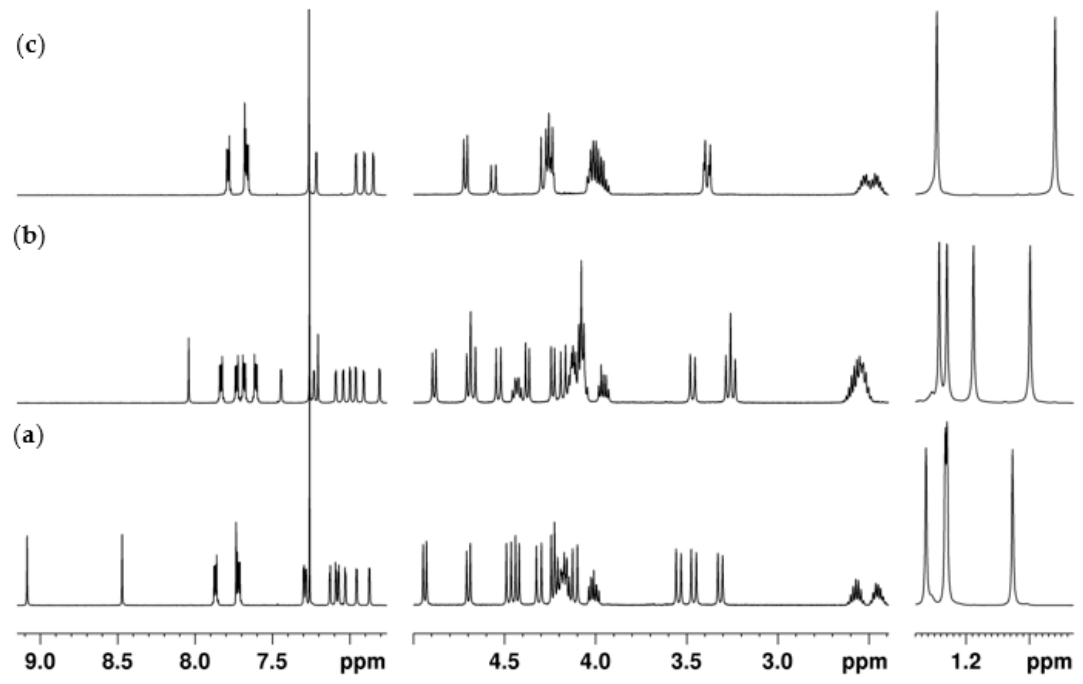
◦ C) of compounds: ( a ) 2a , ( b ) 3a and ( c ) 3b 3 , 22